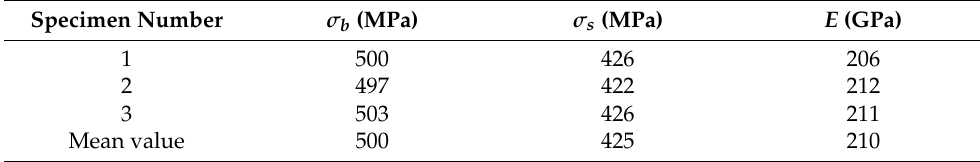
Figure 10. Load–displacement curve of specimens. Table 6. Mechanical property of Q355.